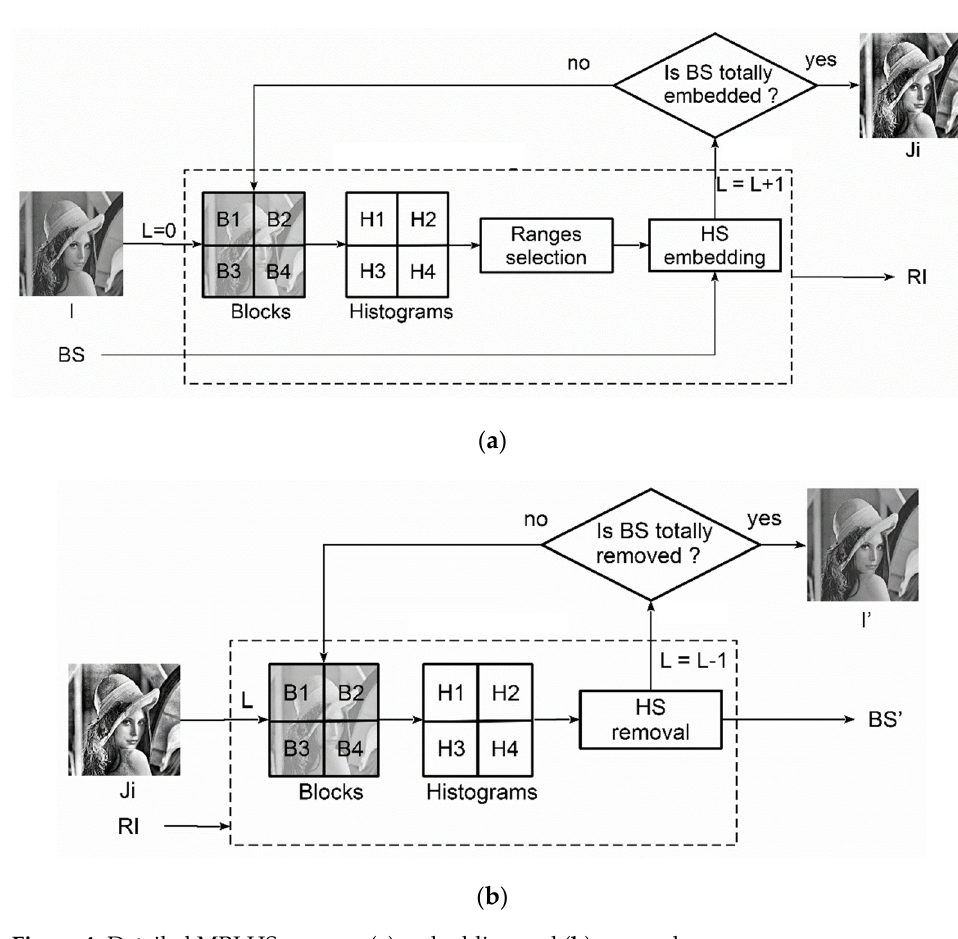
Figure 4. Detailed MRLHS process: ( a ) embedding and ( b ) removal.